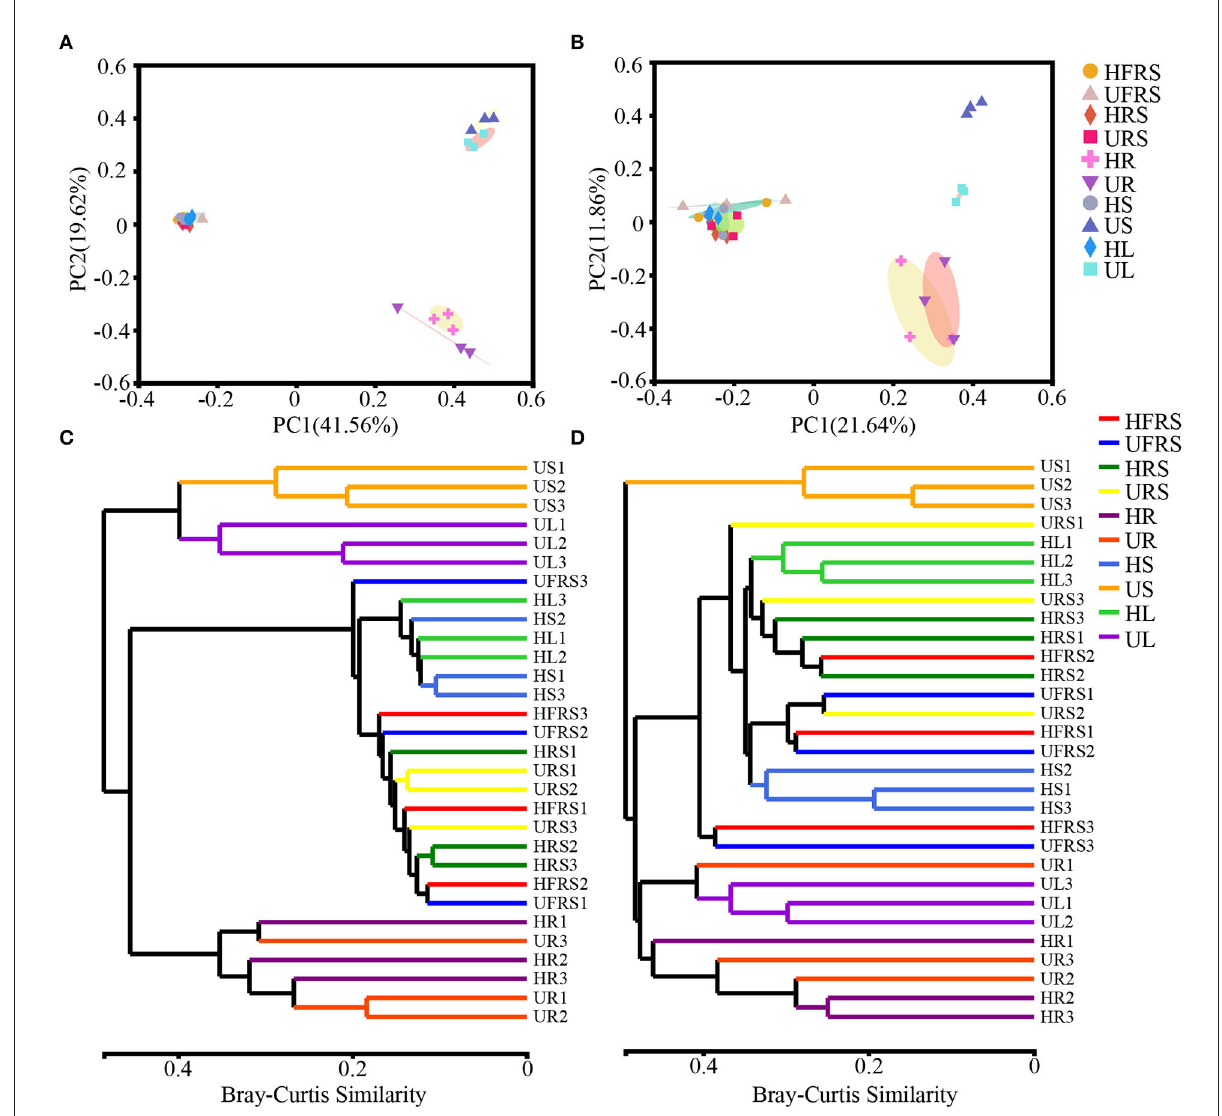
FIGURE2 Composition of the microbial communities in the rhizospheric and bulk soil samples and in different plant compartments (roots, stems, and leaves) of healthy and unhealthy P. bungeana plants was analyzed by principal coordinates analysis (PCoA) and dendrograms constructed using the hierarchical clustering algorithm at the OTU level. PCoA of bacterial (A) and fungal (B) community compositions plotted based on Bray–Curtis distance. The percent of variation explained by PC1 and 2 is given as percent values at respective axes. (C) Bacterial and (D) fungal dendrograms constructed by hierarchical clustering of microbial communities. PCoA was based on the rarefaction curve of the minimum sample sequence number. Hierarchical clustering was based on the Bray–Curtis distance and superimposed on PCoA plots. The OTUs were constructed using a sequence similarity threshold of 97%. Abbreviations of variables are given in Figure